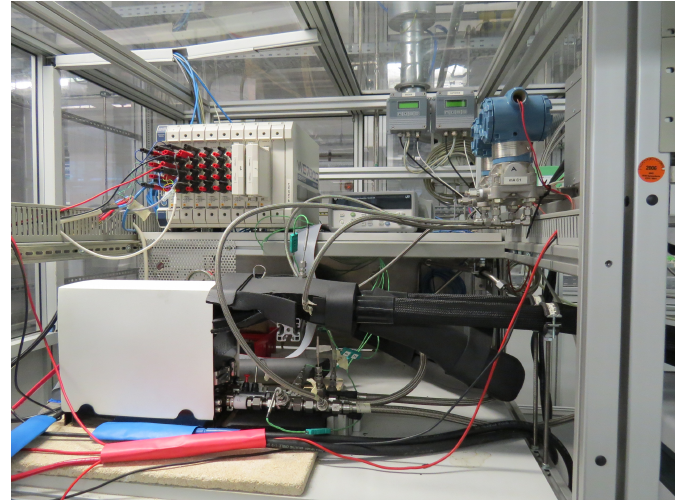
Figure 5. Experimental setup: 46 cells PEM FC stack from Ballard Power System.